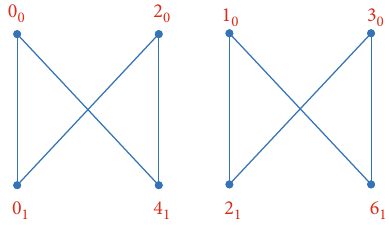
Figure 5: An orthogonal labeling for 2 C